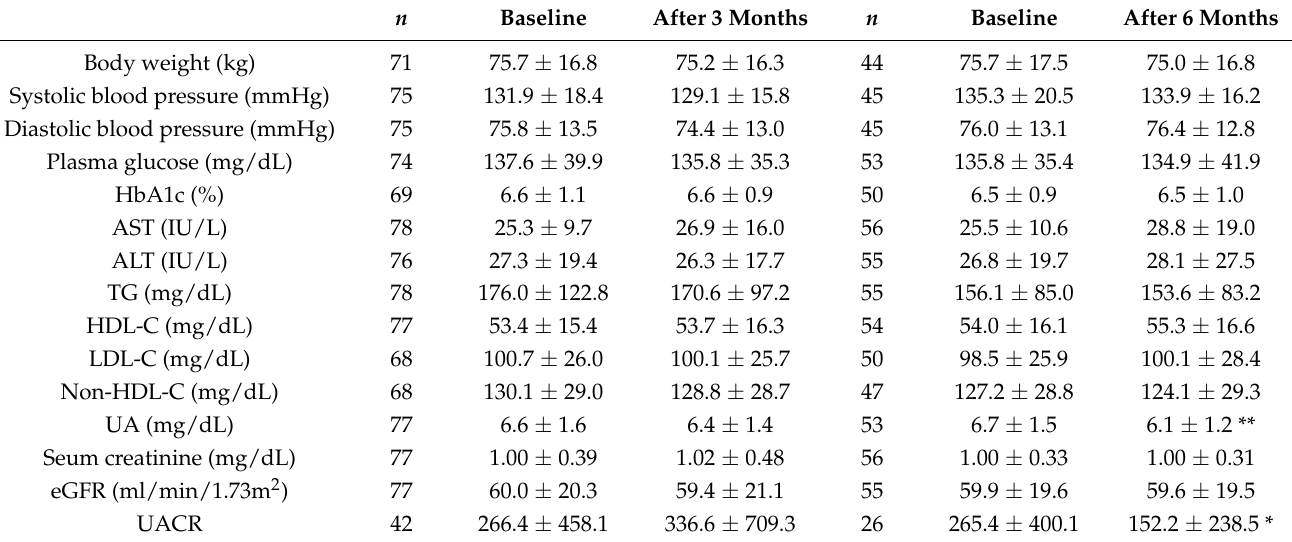
Table 3. Changes in metabolic parameters after the strart of dotinurad in all patients ( n =